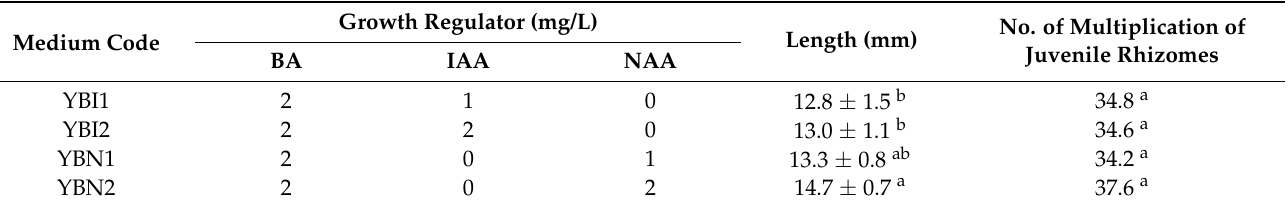
Table 4. Effect of BA combined with IAA or NAA on growth and proliferation of G. elata juvenile rhizomes in culture medium for 8